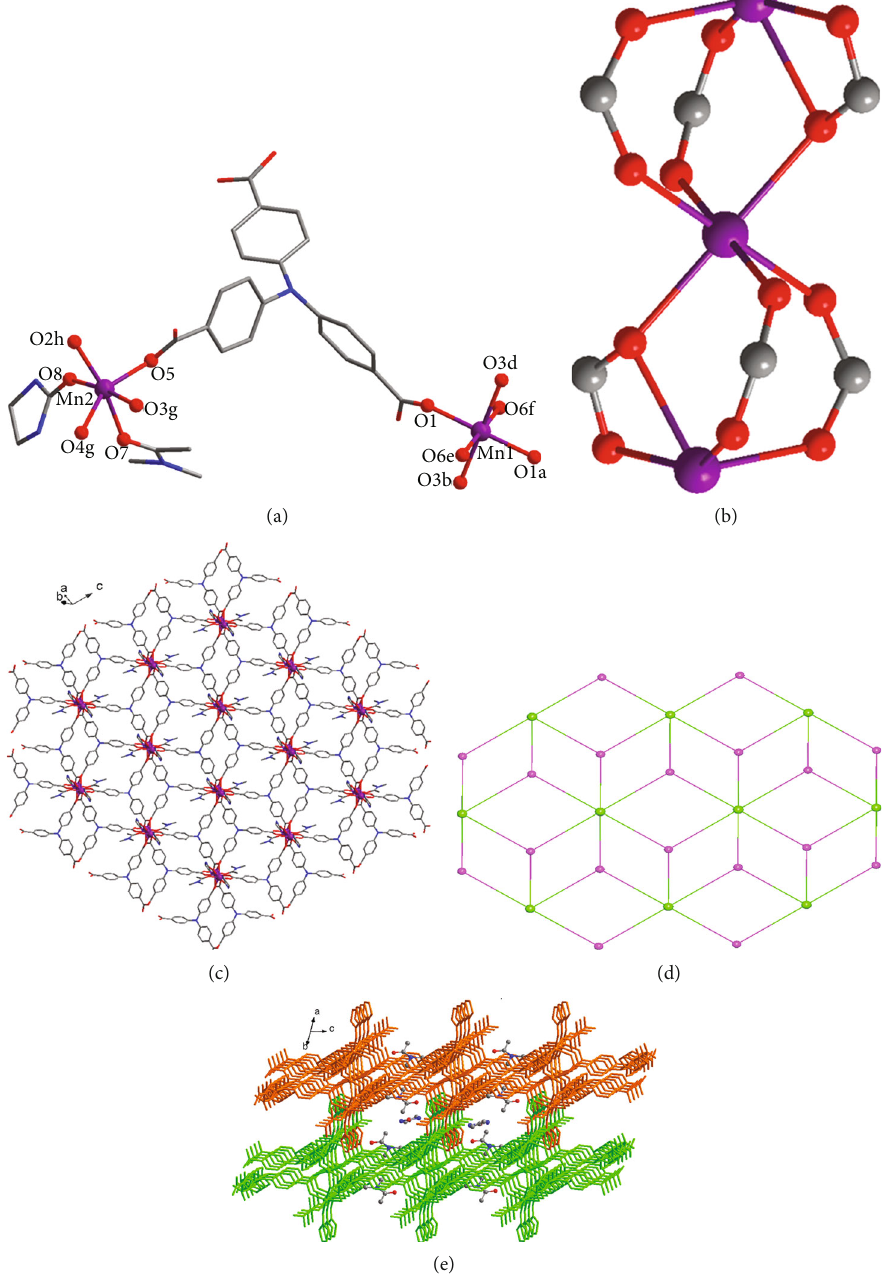
Figure 1: (a) Perspective view of the coordination environments of Mn(II) ions in 1. (b) Linear trinuclear [Mn subunit. (c) Two-dimensional layered framework of 1. (d) The (3,6)-linked kgd topological net for 1. (e) Stacked 3D supramolecular framework of 1 with the free voids occupied by the lattice DMA and e-urea